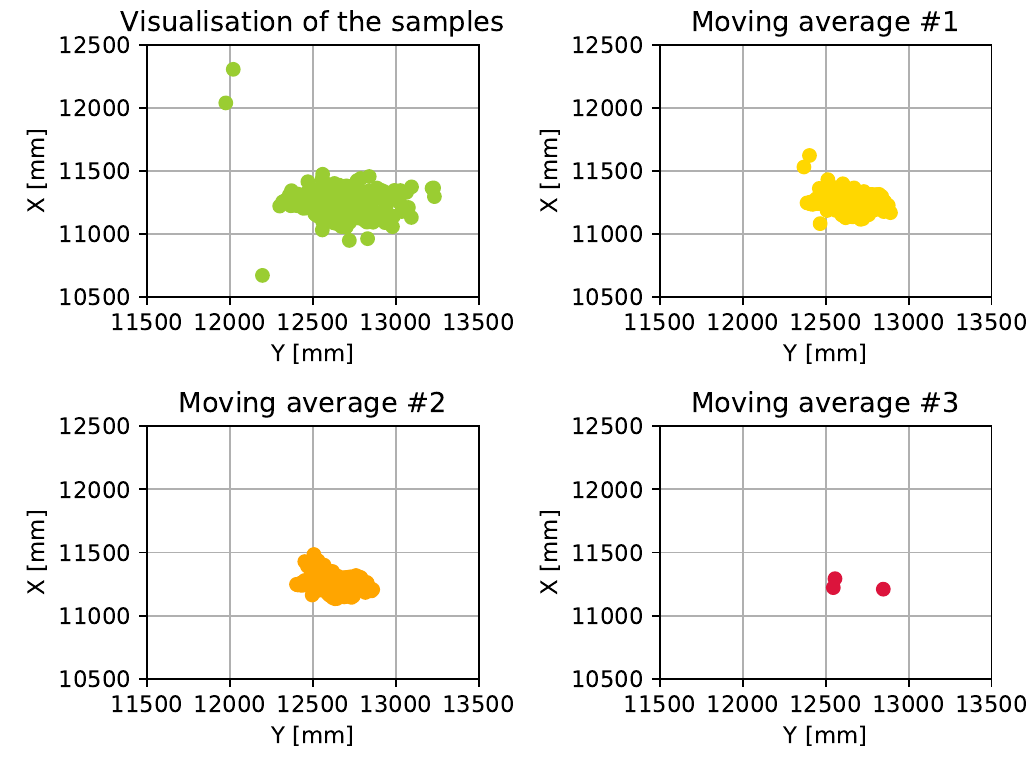
Figure 10. Using moving average with different window sizes.